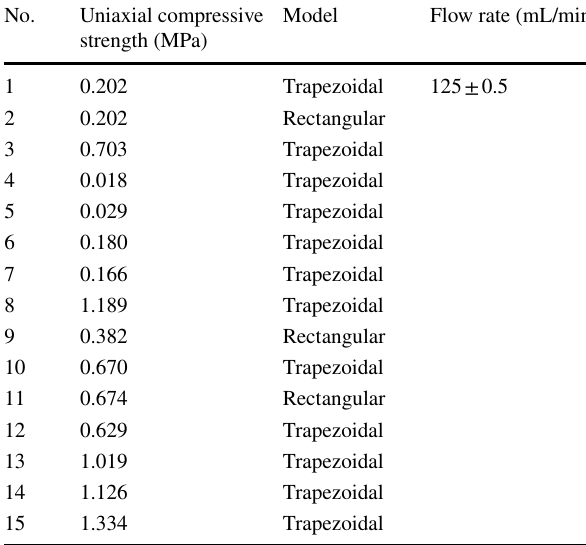
Table 1 A summary table of all testing